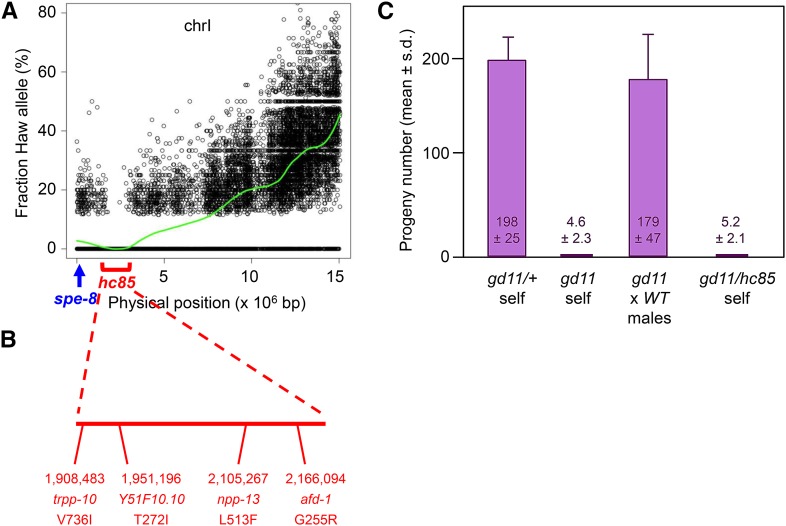
Polymorphism mapping from small input sample. A. Mapping data for spe-48(hc85) allele. Mapping interval (red bracket highlighting SNP gap at 1.7−2.7 Mb) differs from position of spe-8 (blue arrow at position 0.1 Mb). B. Physical map of candidate mutations in the spe-48(hc85) mapping interval. Position, gene name, and amino acid change are indicated. C. Fertility data from the CRISPR allele spe-48(gd11). Mean progeny counts with standard deviations (n = 10 hermaphrodites) are shown for the indicated genotypes.